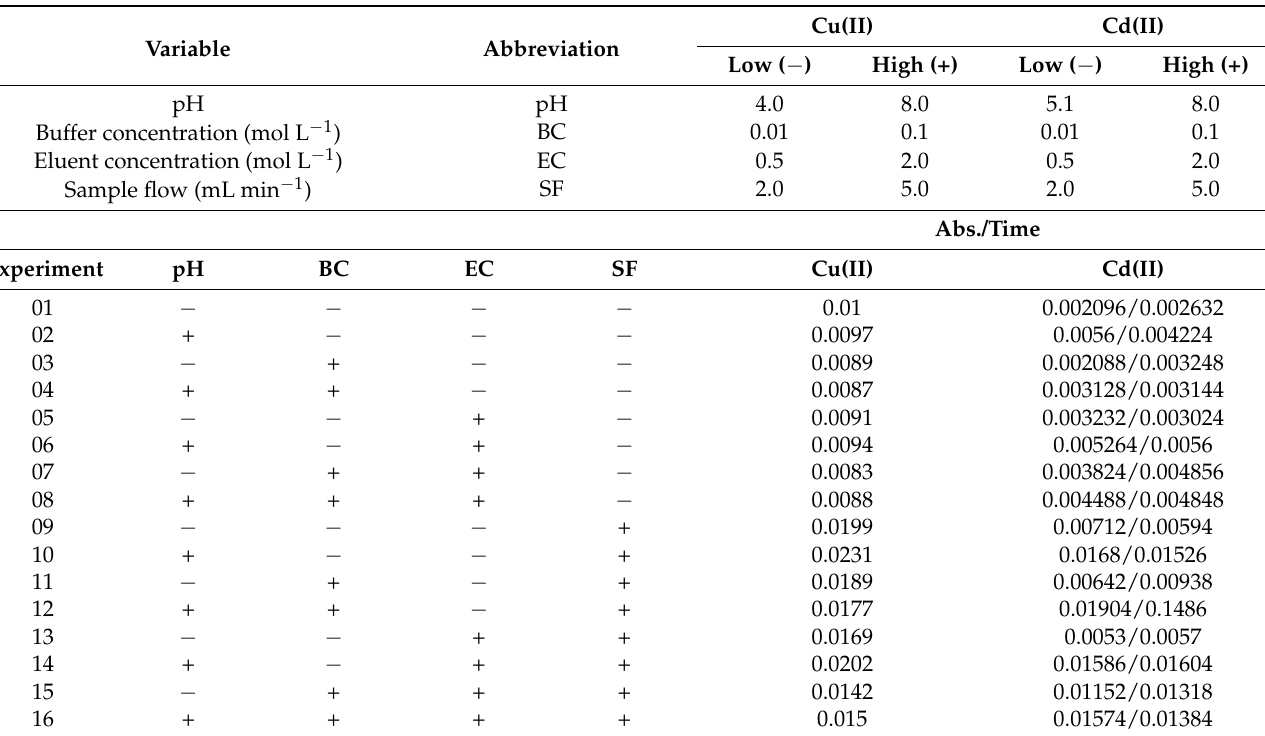
Table 5. Levels of variables for the 24 factorial planning, matrix and the results of the planning towards the determination of Cu(II) and Cd(II) through the preconcentration system.